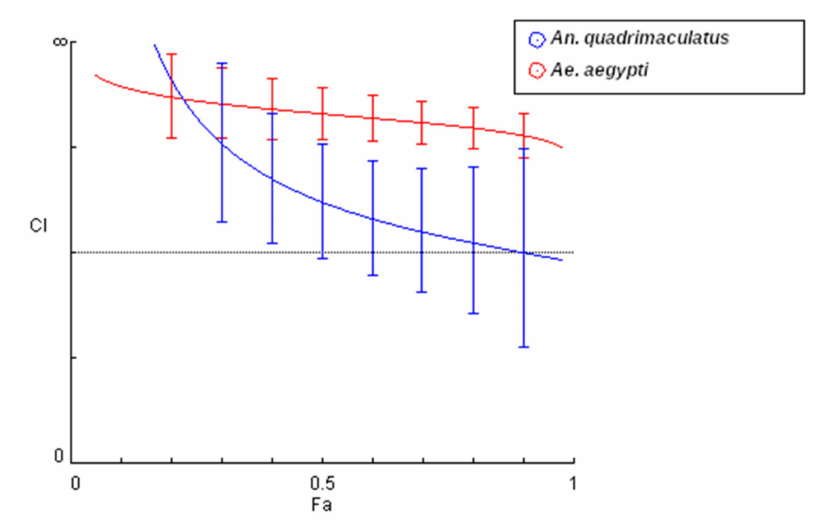
Figure 4. Combination index ( CI ) plot showing the simulated relationship between DL-methionine and Bacillus thuringiensis subspecies israelensis (BTI) for Anopheles quadrimaculatus (blue; n = 4) and Aedes aegypti (red; n = 6) exposed for 48 h in glass jars. Error bars are 95% confidence intervals around a mean calculated by sequential deletion analysis (S.D.A.). CI less than 1 (below the dotted line) indicates synergism. Lethality fraction ( f a ) a ff ected as a proportion on the x-axis. Simulated and plotted using the software Compusyn